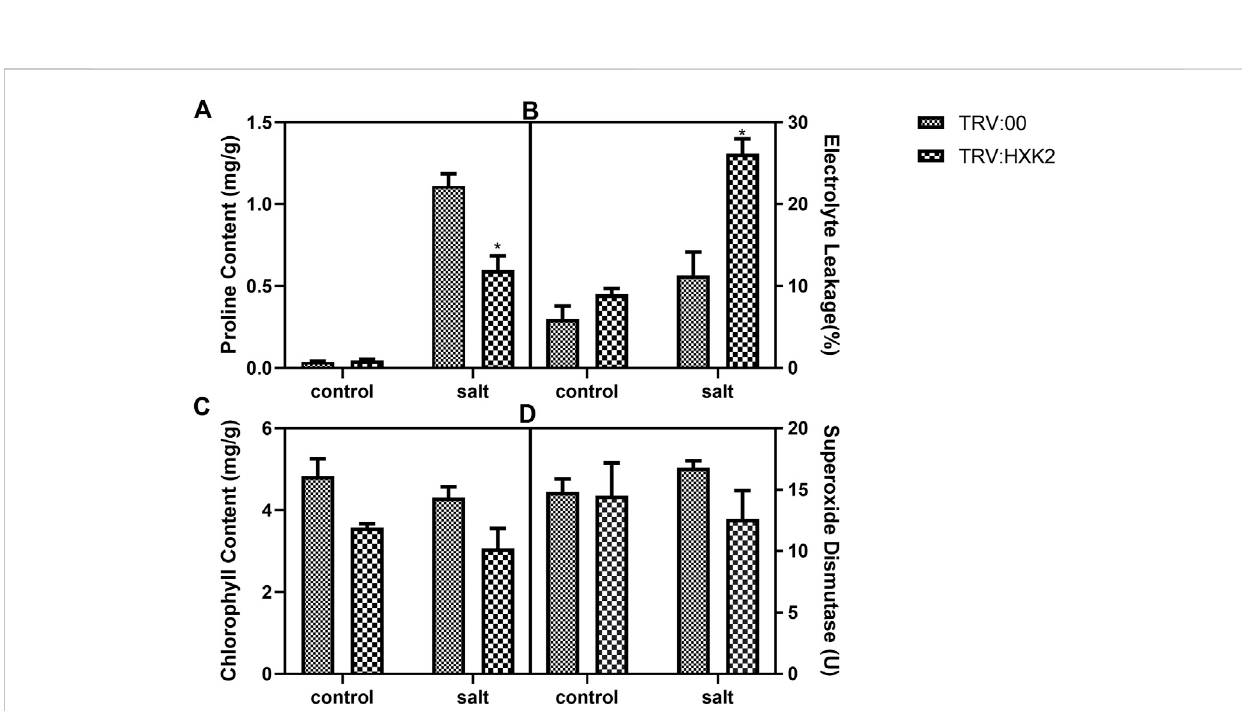
FIGURE 7 Physiological response of GmHXK2 silent plant under salt stress. Content of proline (A) , EL (B) , chlorophyll (C) and SOD (D) were measured in TRV: 00 and TRV: HXK2 after treatment with 0 or 200 mM NaCl for 5-days. Data are presented as mean ± SE. Single asterisks denotes signi fi cant differences compared to the values of TRV:00 at p < 0.05; Student ’ s